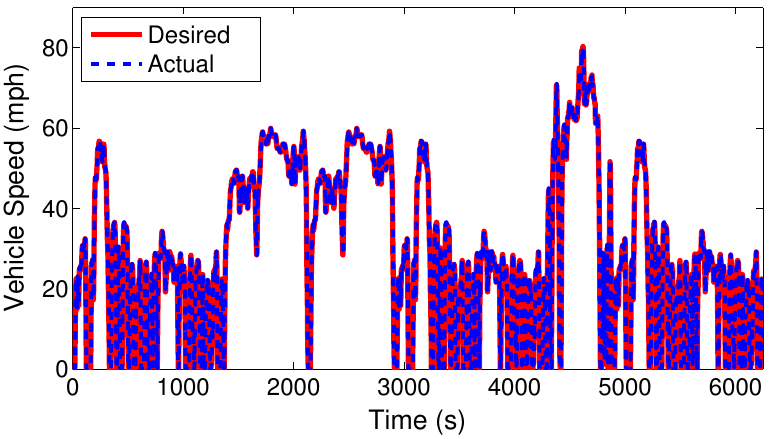
Figure 11. Desired vehicle speed vs. actual vehicle speed with a root mean square tracking error of 0.8